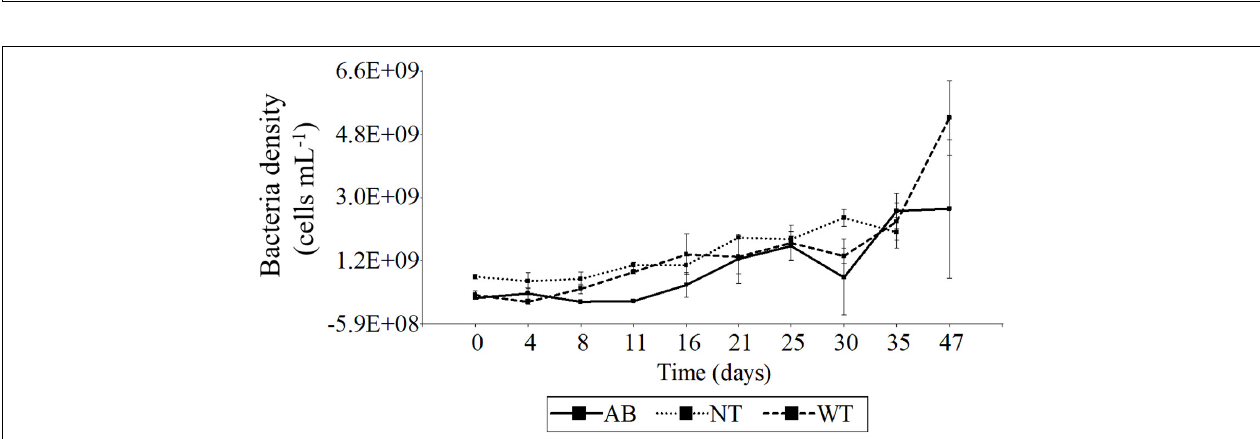
FIGURE 6 | Epifluorescence microscopy after DAPI staining of bacteria in Prorocentrum PA1 cultures showing apparent increase in bacterial cell density over time in all treatments: AB, washed cells plus antibiotics; WT, washed cells; NT, non-treated culture (control). 1000X magnification.